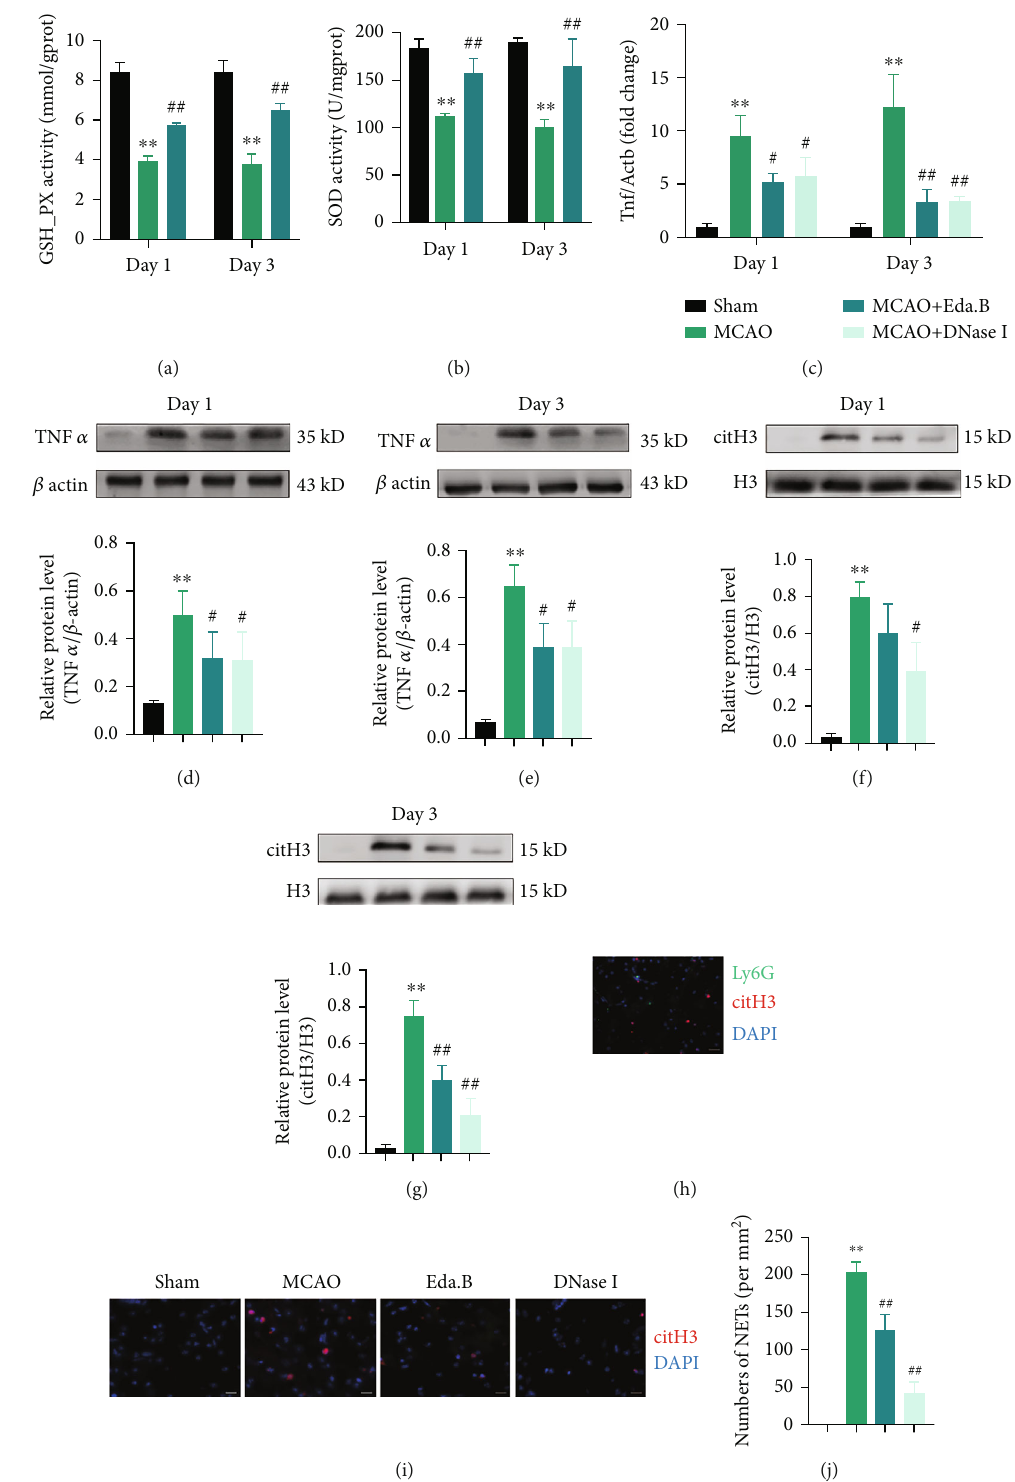
Figure 4: Protective e ff ects of Eda.B against NETs and in fl ammatory factors. (a, b) The levels of GSH-Px and SOD in di ff erent groups were quanti fi ed by commercial kits. (c) mRNA expression of Tnf in mouse cortex at day 1 and day 3 after stroke.(d – g) Protein levels of TNF α and citH3 at day 1 and day 3 after stroke. Representative bands are on the top. (h) Representative images of sections stained with citH3 (red), neutrophil marker Ly6G (green), and DAPI (blue) in infarct cortex. Scale bar = 20 μ m. (i, j) Representative images of sections stained with citH3 (red) and DAPI (blue) in infarct cortex and quanti fi cation of NETs in di ff erent groups. Scale bar = 40 μ m. ∗∗ P < 0 : 01 (MCAO group vs. Sham group), # P < 0 : 05 (Eda.B group or DNase I group vs. MCAO group), and ## P < 0 : 01 (Eda.B group or DNase I group vs. MCAO group), n = 5 in each